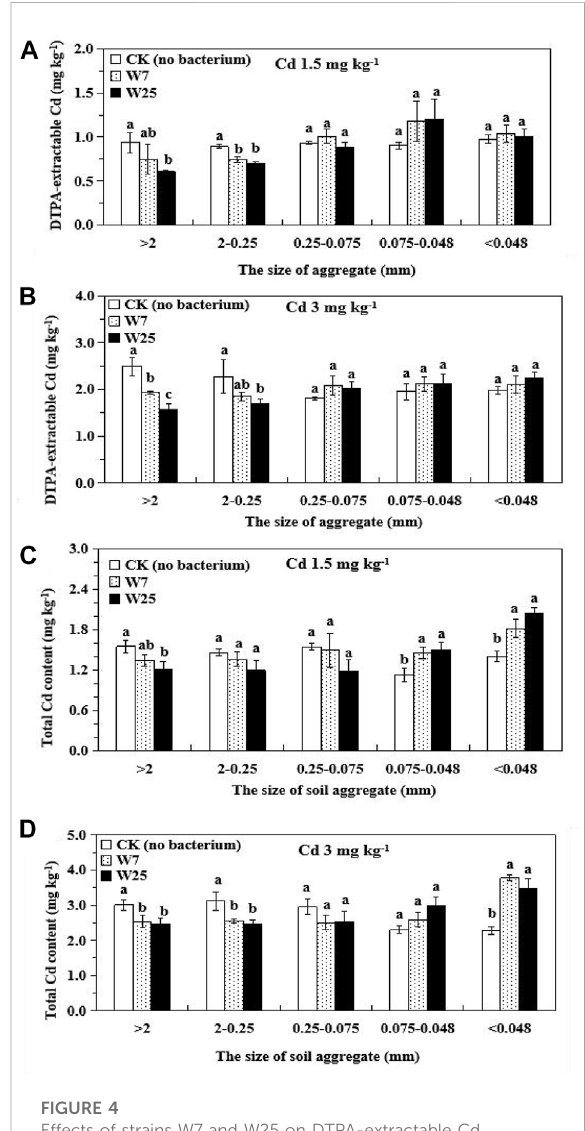
FIGURE 4 Effects of strains W7 and W25 on DTPA-extractable Cd contents (A,B) andtotalCdcontents (C,D) ofsoilaggregatesinlow and high Cd-contaminated rhizosphere soils of wheat. Error bars are ± standard error ( n = 3). Bars with the same letter within each treatment are not signi fi cantly different ( p > 0.05) according to Tukey ’ s